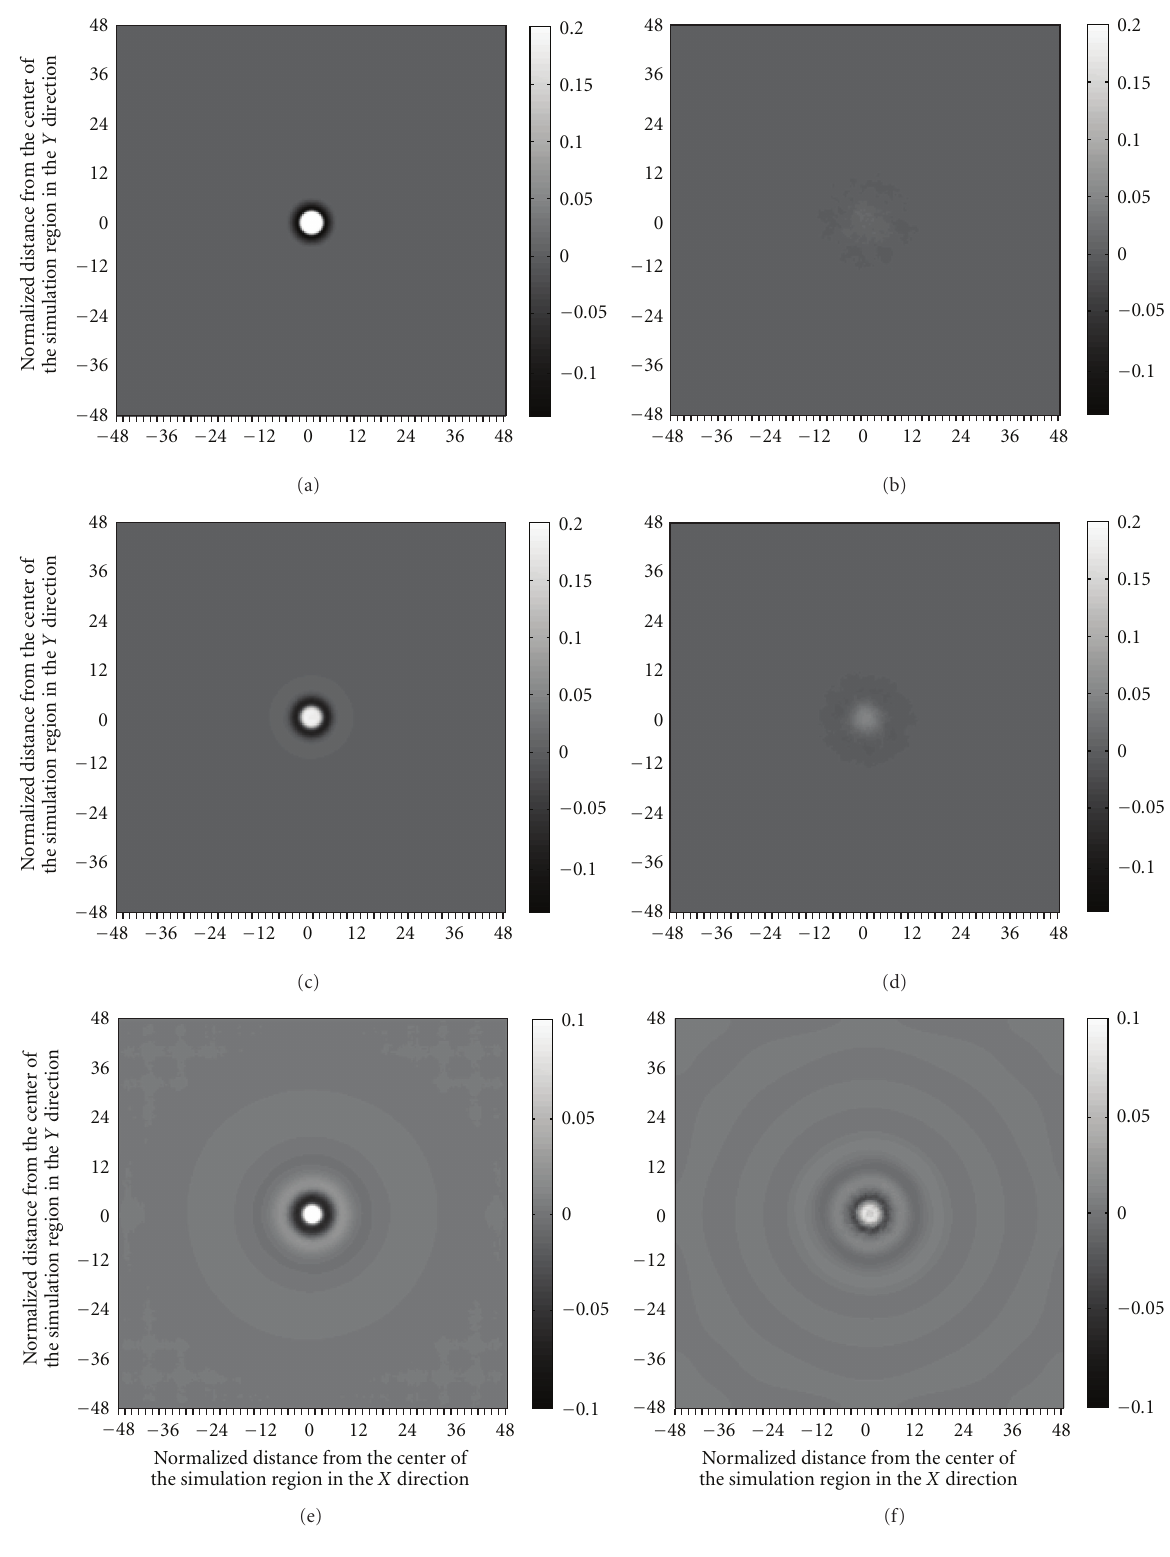
Normalized distance from the center of the simulation region in the X direction (f) Figure 3: The calculated spatial distributions of the relative decrease of the electron concentration, ( n 0 − n e ) /n 0 in the plane perpendicular and Y /λ 0 D , that is, the distances in units of the Debye length, λ 0 D , from the central to the magnetic field. The normalized distances, X /λ 0 D e e e point of the simulation region are shown on the horizontal ( X ) and vertical ( Y ) axes. The results, obtained for the second situation when the temporal evolution of the initially created irregularity was studied, are given for the following moments: (a) t = 0, (b) t = T pe , (c) t = 3 · T t = 4 . 4 · T t = 14 . 09 · T t = 2 . 2 · T pe , (d) pe , (e) pe , and (f) pe